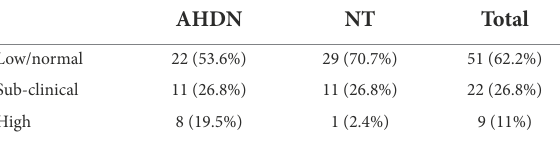
TABLE 2 Number and percentage of children with parent-reported low/normal, sub-clinical and high anxiety. AHDN